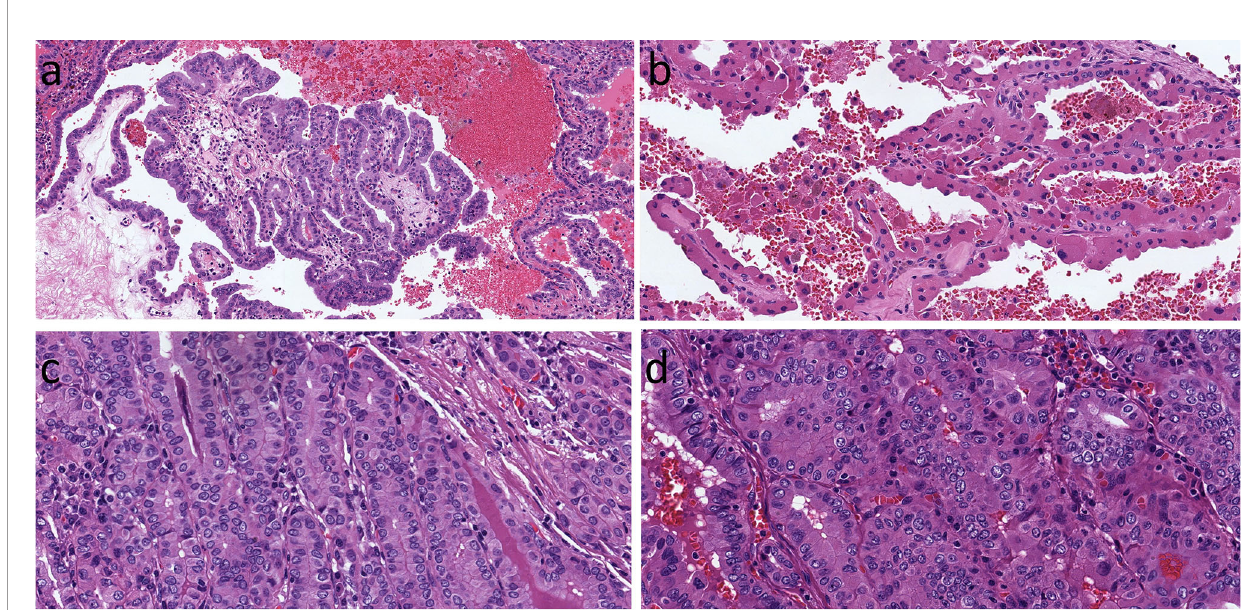
FIGURE 6 | Oncocytic Classic Papillary Thyroid Carcinoma. A classical papillary thyroid carcinoma has oncocytic cytology of the columnar cells lining a complex papilla (A) . In this example, the oncocytic cells are more polygonal and cuboidal (B) . When the oncocytic cells are crowded, there is a super fi cial resemblance to tall cell papillary thyroid carcinoma, but careful inspection shows that the height-to-width ratio does not exceed 3:1 (C) . The oncocytic cells can have variable shapes and sizes (D) , however in all of these examples, the nuclear features of papillary caricnoma are readily